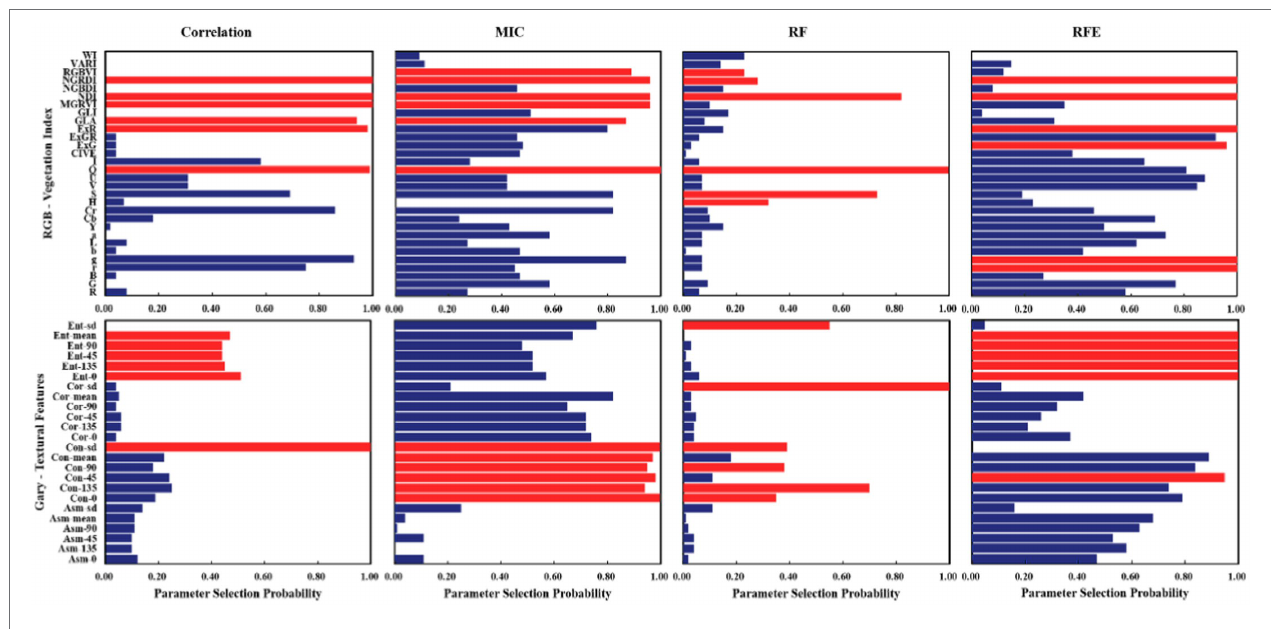
FIGURE 5 | Optimal feature selection based on different screening